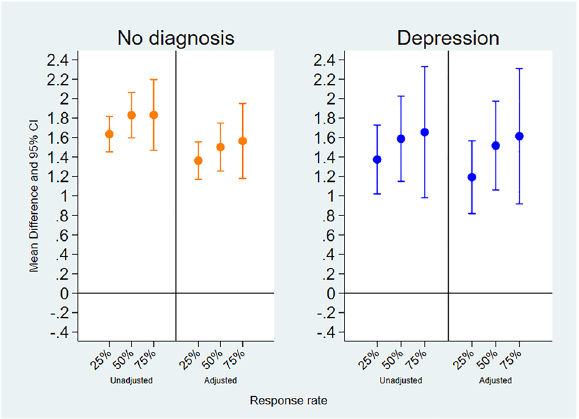
Figure 3. Associations of momentary mental wellbeing scores in relation to seeing or hearing birds in participants with no diagnosis of mental health condition and those with a diagnosis of depression. Associations are shown unadjusted and adjusted for age, gender, education, occupational status, ethnicity, whether participants could see trees, plants, and see or hear water. The vertical axis represents the mean difference (MD) and 95% confidence intervals (95% CI) of mental wellbeing score when seeing or hearing birds. The horizontal axis represents the assessments lagged from 0 to 2. L0 indicates the impact of seeing or hearing birds on mental wellbeing at the time of the assessment. L1 indicates the impact of seeing or hearing birds on mental wellbeing during the subsequent assessment. L2 indicates the impact of seeing or hearing birds on mental wellbeing in the second subsequent